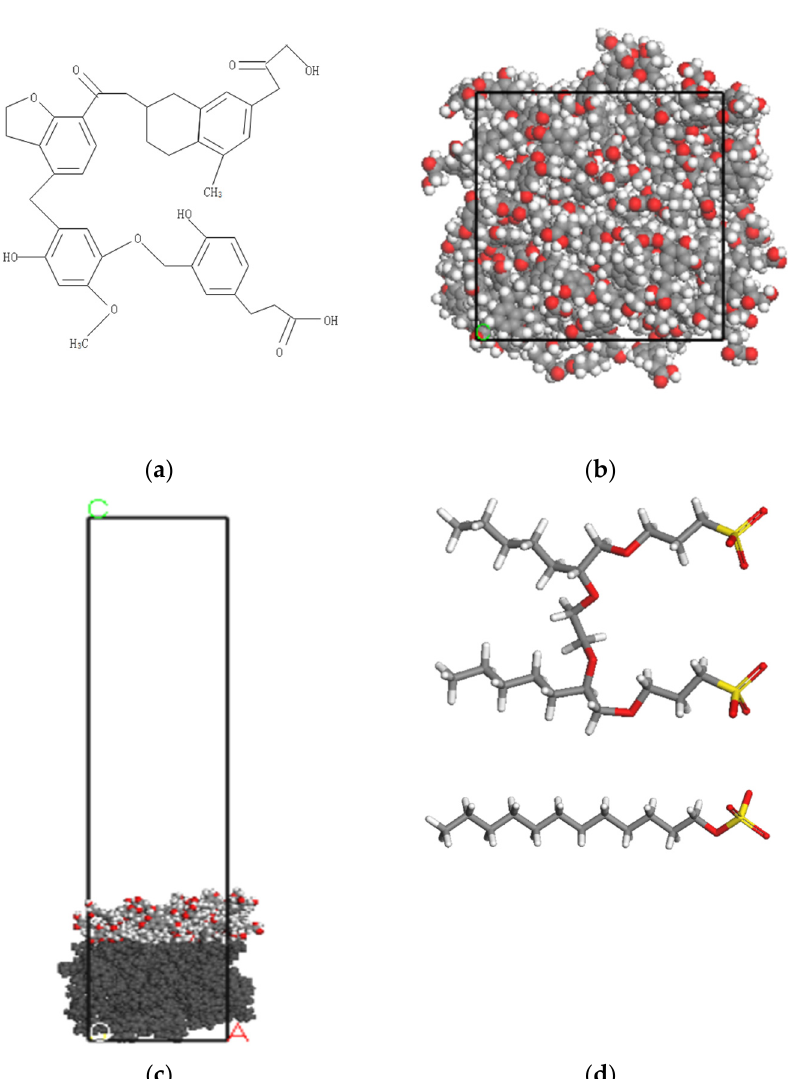
Figure 1. ( a ) Wender lignite molecular structure ( b ) Top view of lignite 3D structure model ( c ) Side view of lignite 3D structure model ( d ) S2 and SDS ions (red is oxygen atom, yellow is sulfur atom, white is hydrogen atom, gray is carbon atom, the black part represents the fixed part). In Figure ( c ), the white O represents the origin, the red A represents the direction of the X axis, and the green C represents the direction of the Z axis. In the following, the yellow B represents the y-axis direction